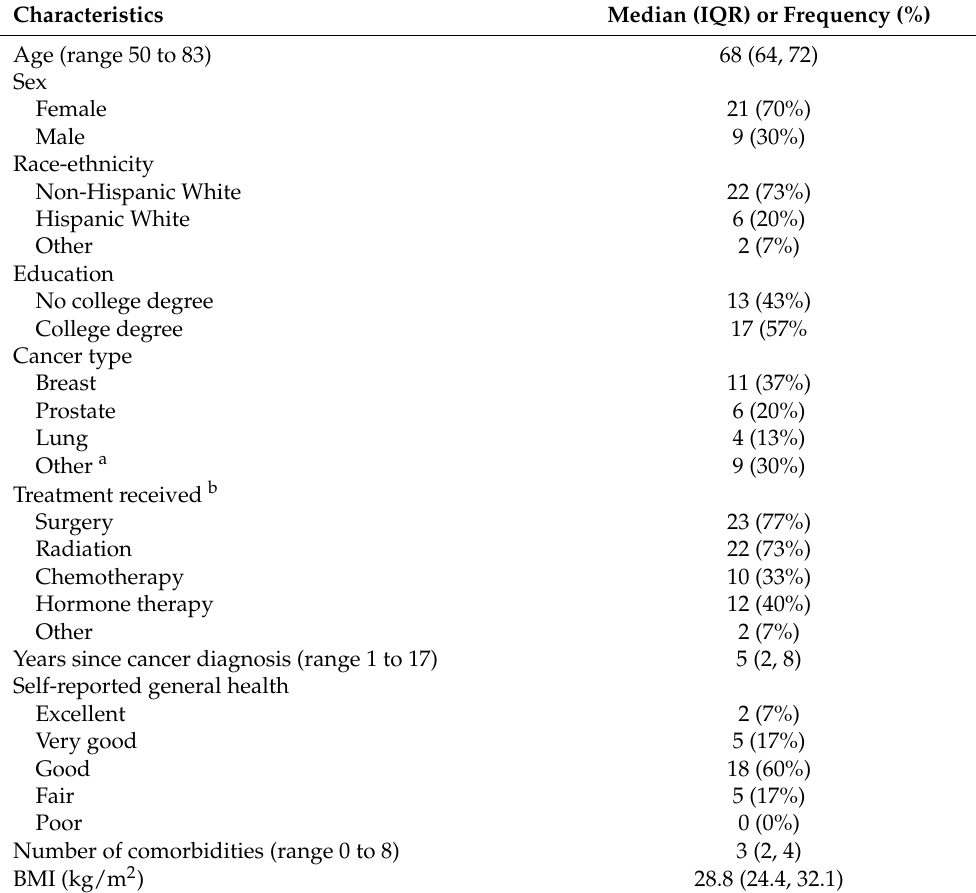
Table 1. Baseline characteristics of the cancer survivors participating in Southwest Harvest for Health.